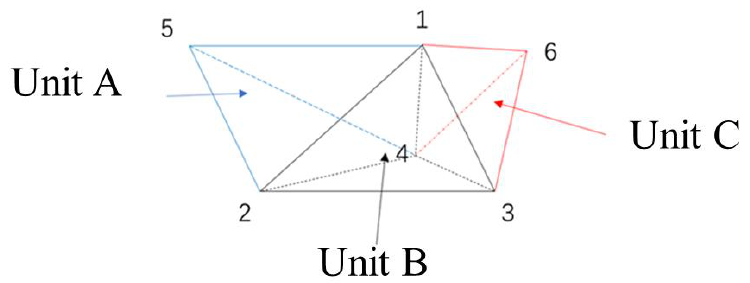
Figure 6. A model consisting of three tetrahedral units.